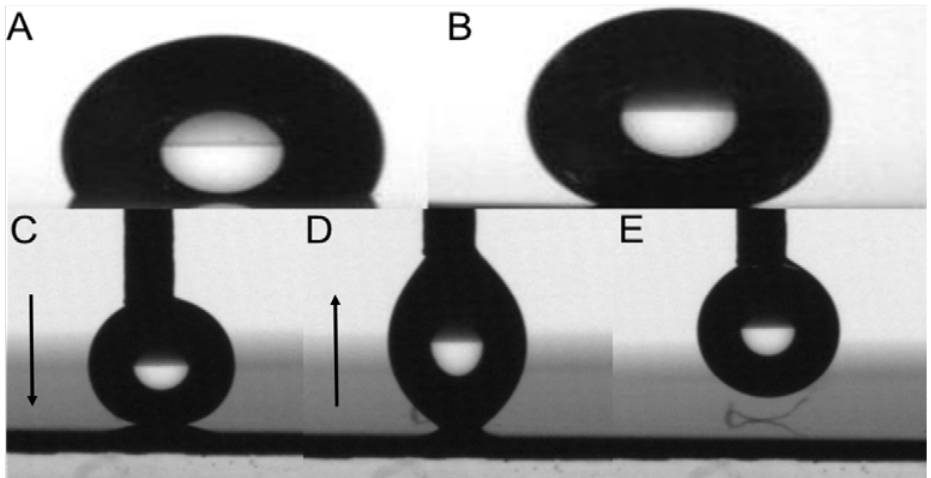
Figure 3. ( A ) water droplet on the glass coated with S 22 (Θ = 110°) and ( B ) on the glass coated with S 22 after rinsing with ethyl acetate (Θ = 140°) (both after annealing). The “ball jump motion” phenomenon—advancing ( C ) and receding ( D , E ) on anodised aluminium coated with S 22 after annealing and rinsing steps. The Arrows in Figure 3( C , D ) indicate the motion of the cannula.